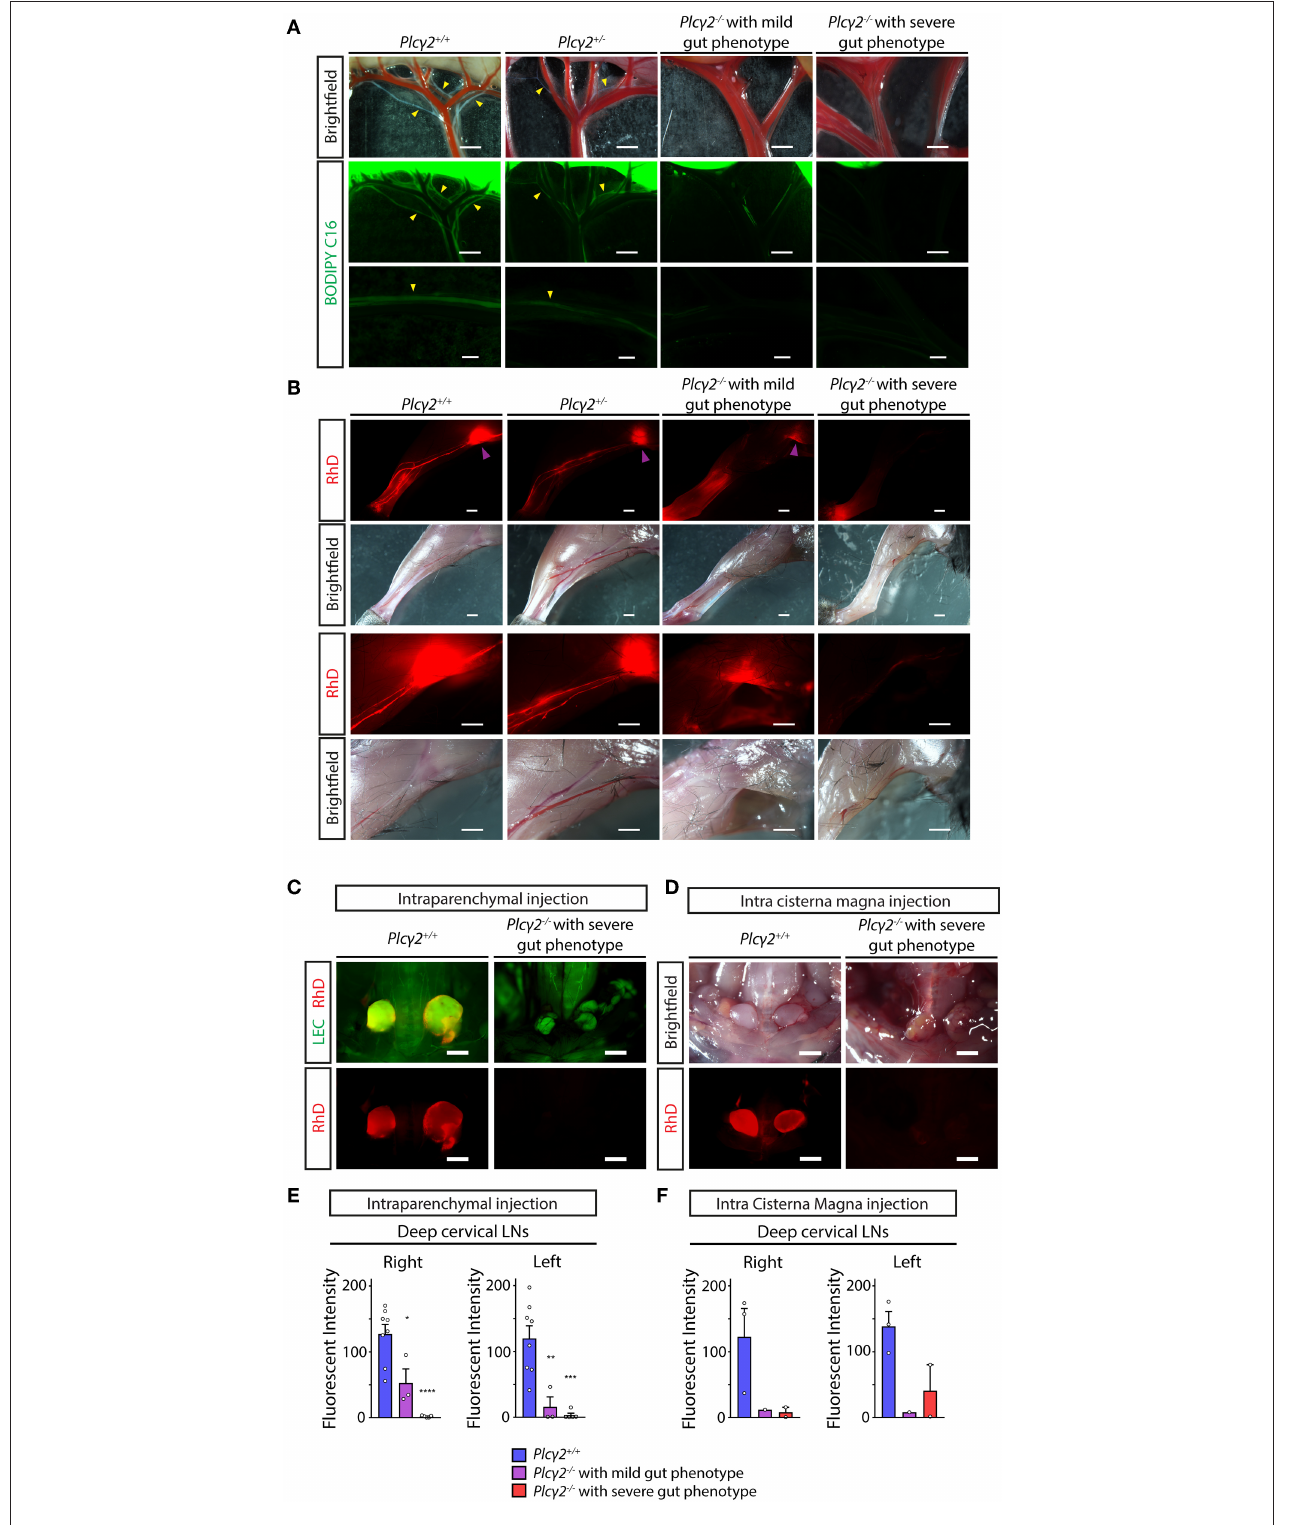
FIGURE 7 | Characterization of lymphatic function in Plc γ 2 − / − and littermate control mice. (A) Representative images are shown for uptake and drainage of BODIPY C 16 by mesenteric lymphatic vessels of young adult Plc γ 2 + / + , Plc γ 2 + / − and Plc γ 2 − / − mice with mild or severe gut phenotype 2h after feeding with BODIPY C 16 .